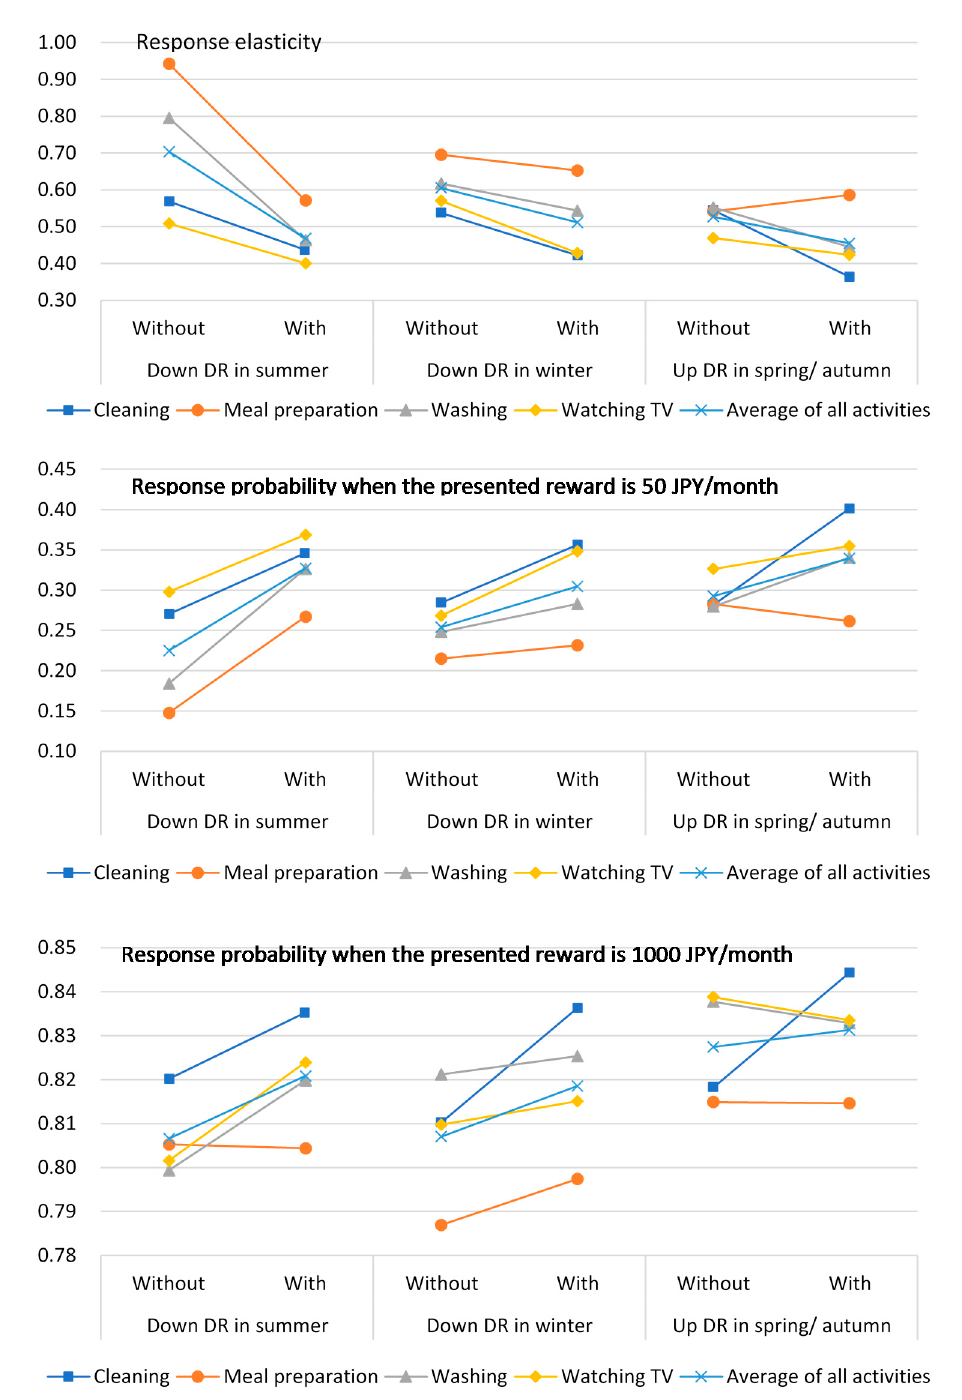
Figure 6. E ff ect of respondents’ perceived e ff ectiveness of DR on response probability (comparison with Figure 6. Effect of respondents’ perceived effectiveness of DR on response probability (comparison and without the perceived e ff ectiveness of DR before providing knowledge about DR e ff with and without the perceived effectiveness of DR before providing knowledge about DR effectiveness).